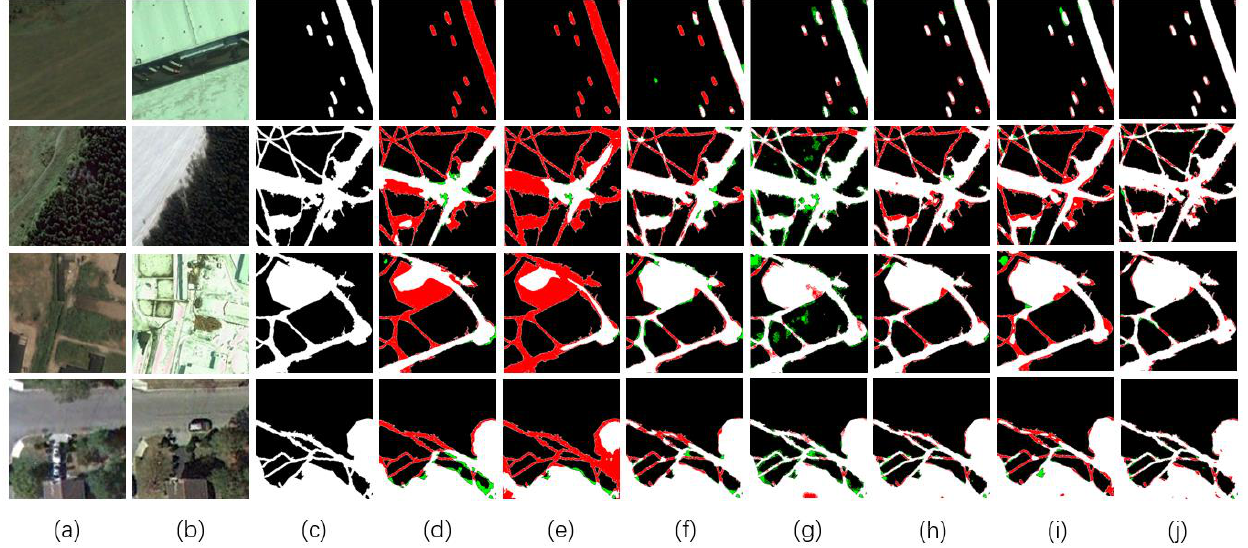
Figure 9. Visualization results of different methods for CDD datasets. ( a ) T1 images. ( b ) T2 images. ( c ) Ground truth. ( d ) FC-Conc. ( e ) FC-Diff. ( f ) IFN. ( g ) DDCNN. ( h ) SNUNet. ( i ) BIT. ( j ) Ours. In the figure, white, black, red, and green represent TP, TN, FN, and FP, respectively. In the CDD data, we trained 100 epochs for each comparison network to obtain Table